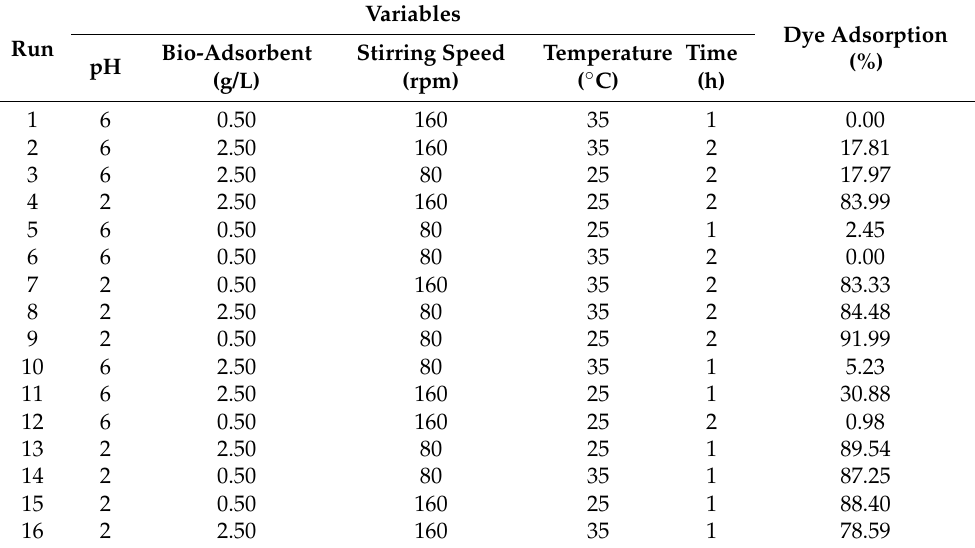
Table 2. Design matrix for 2 (5 − 1) fractional factorial design and dye adsorption from textile wastew- ater